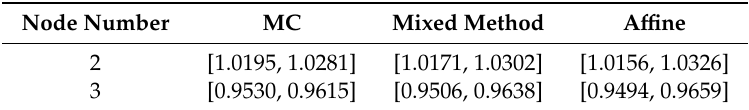
Table 3. Voltage amplitude intervals.